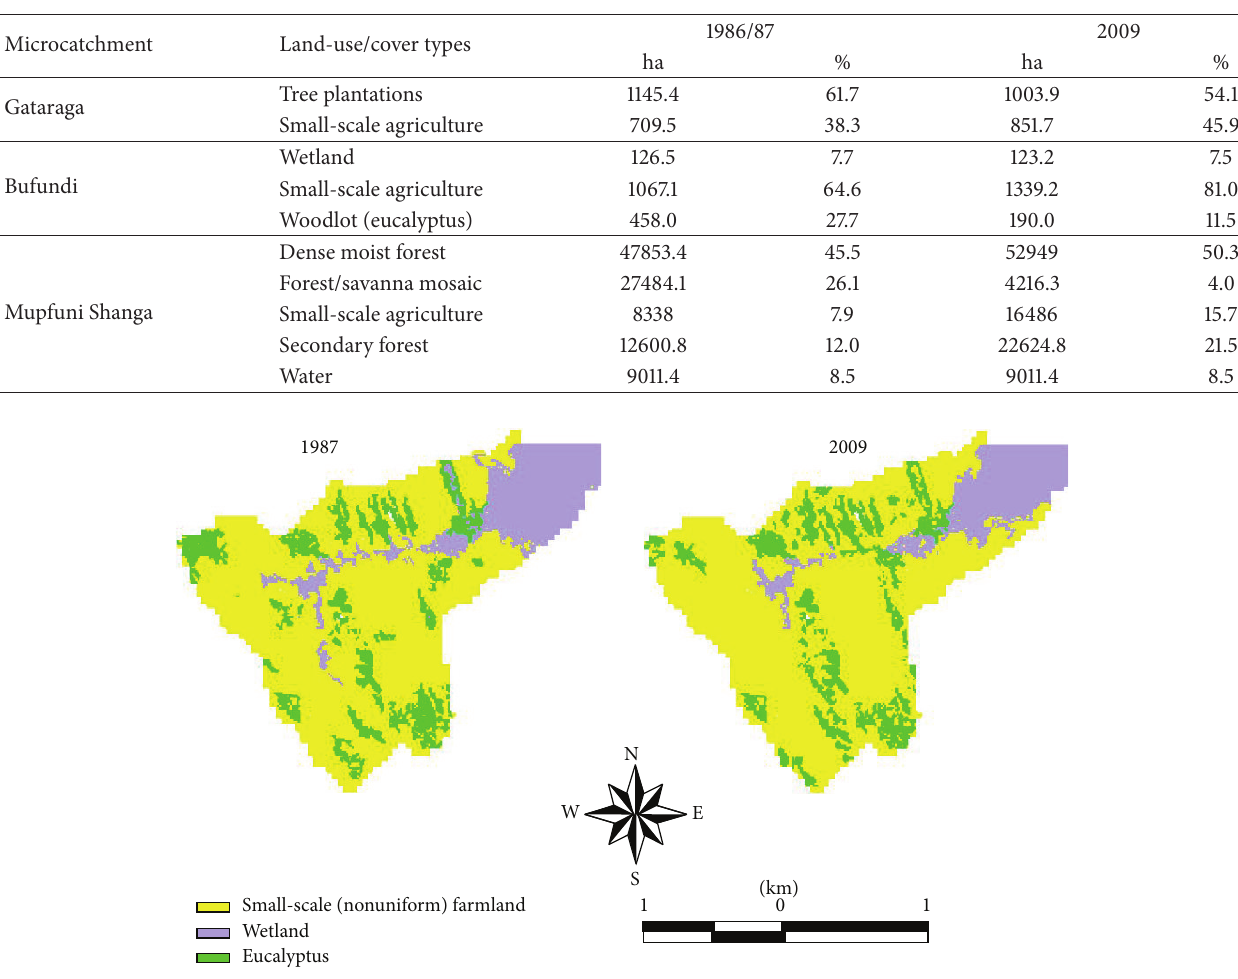
Figure 1: Land-use/cover distribution in Bufundi benchmarked watershed